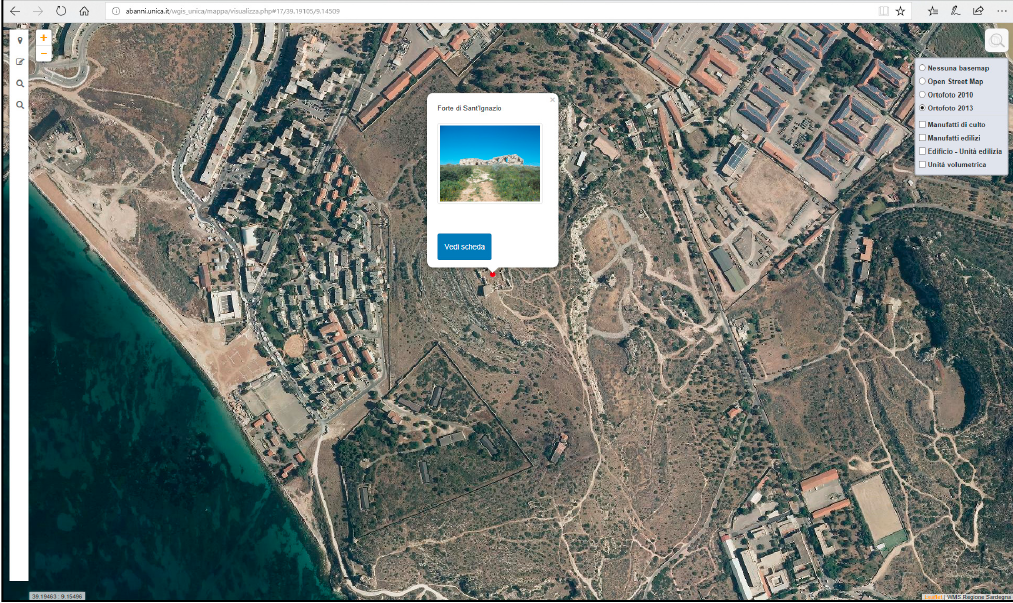
Figure 5. The WebGIS and the Layer Control for the Base Maps (S. Ignazio Fort).